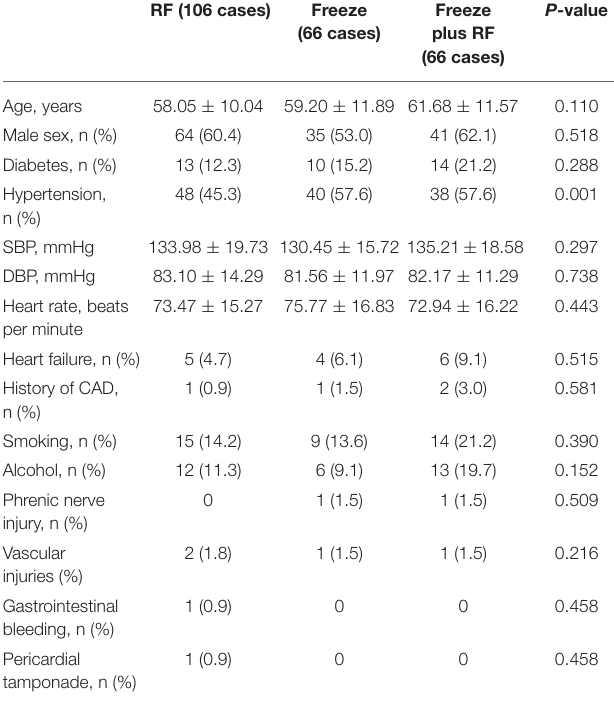
TABLE 1 | Patient characteristics at baseline before